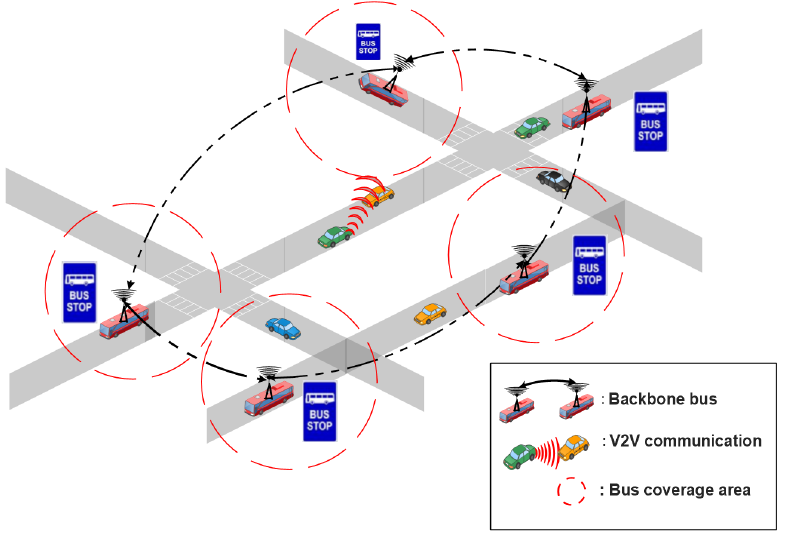
Figure 6. Mobile infrastructure based on backbone bus.